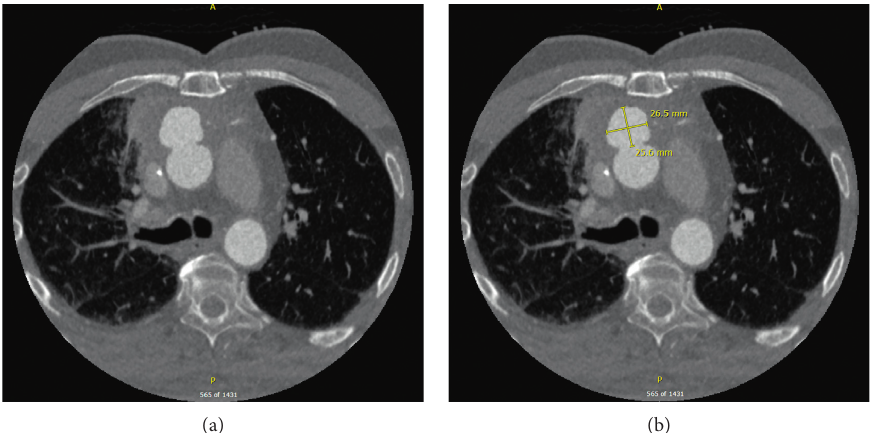
Figure 1: Computed tomography angiography demonstrating a large aortic pseudoaneurysm within the anterior ascending